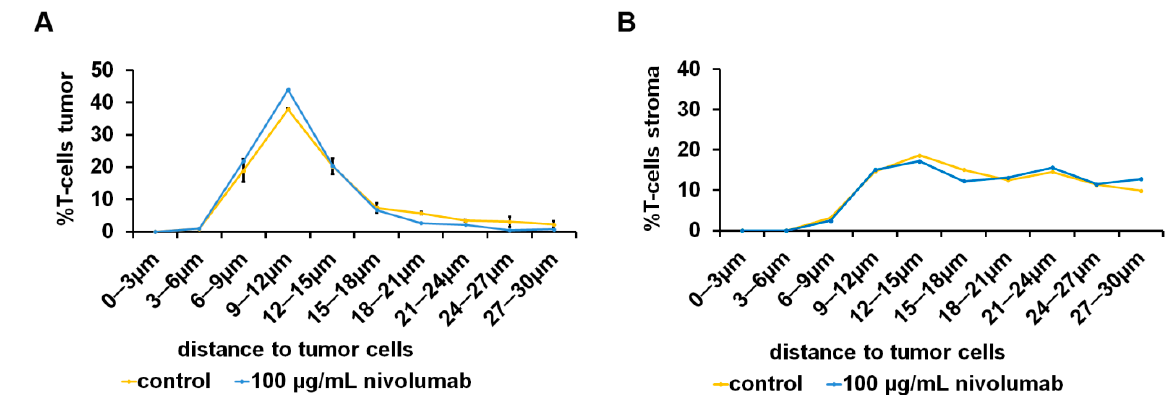
Figure 5. Nivolumab-dependent spatial distribution of tumor infiltrating T-cells. Tumor tissue of clear cell renal cell carcinoma (ccRCC) cultivated 72 h with nivolumab. Tissue slices were immunohistochemically double stained for cytokeratin and CD3. The distance between ( A ) tumor infiltrating T-cells and ( B ) stromal T-cells to tumor cells was calculated by digital image analysis. Data are given as mean ± standard deviation.